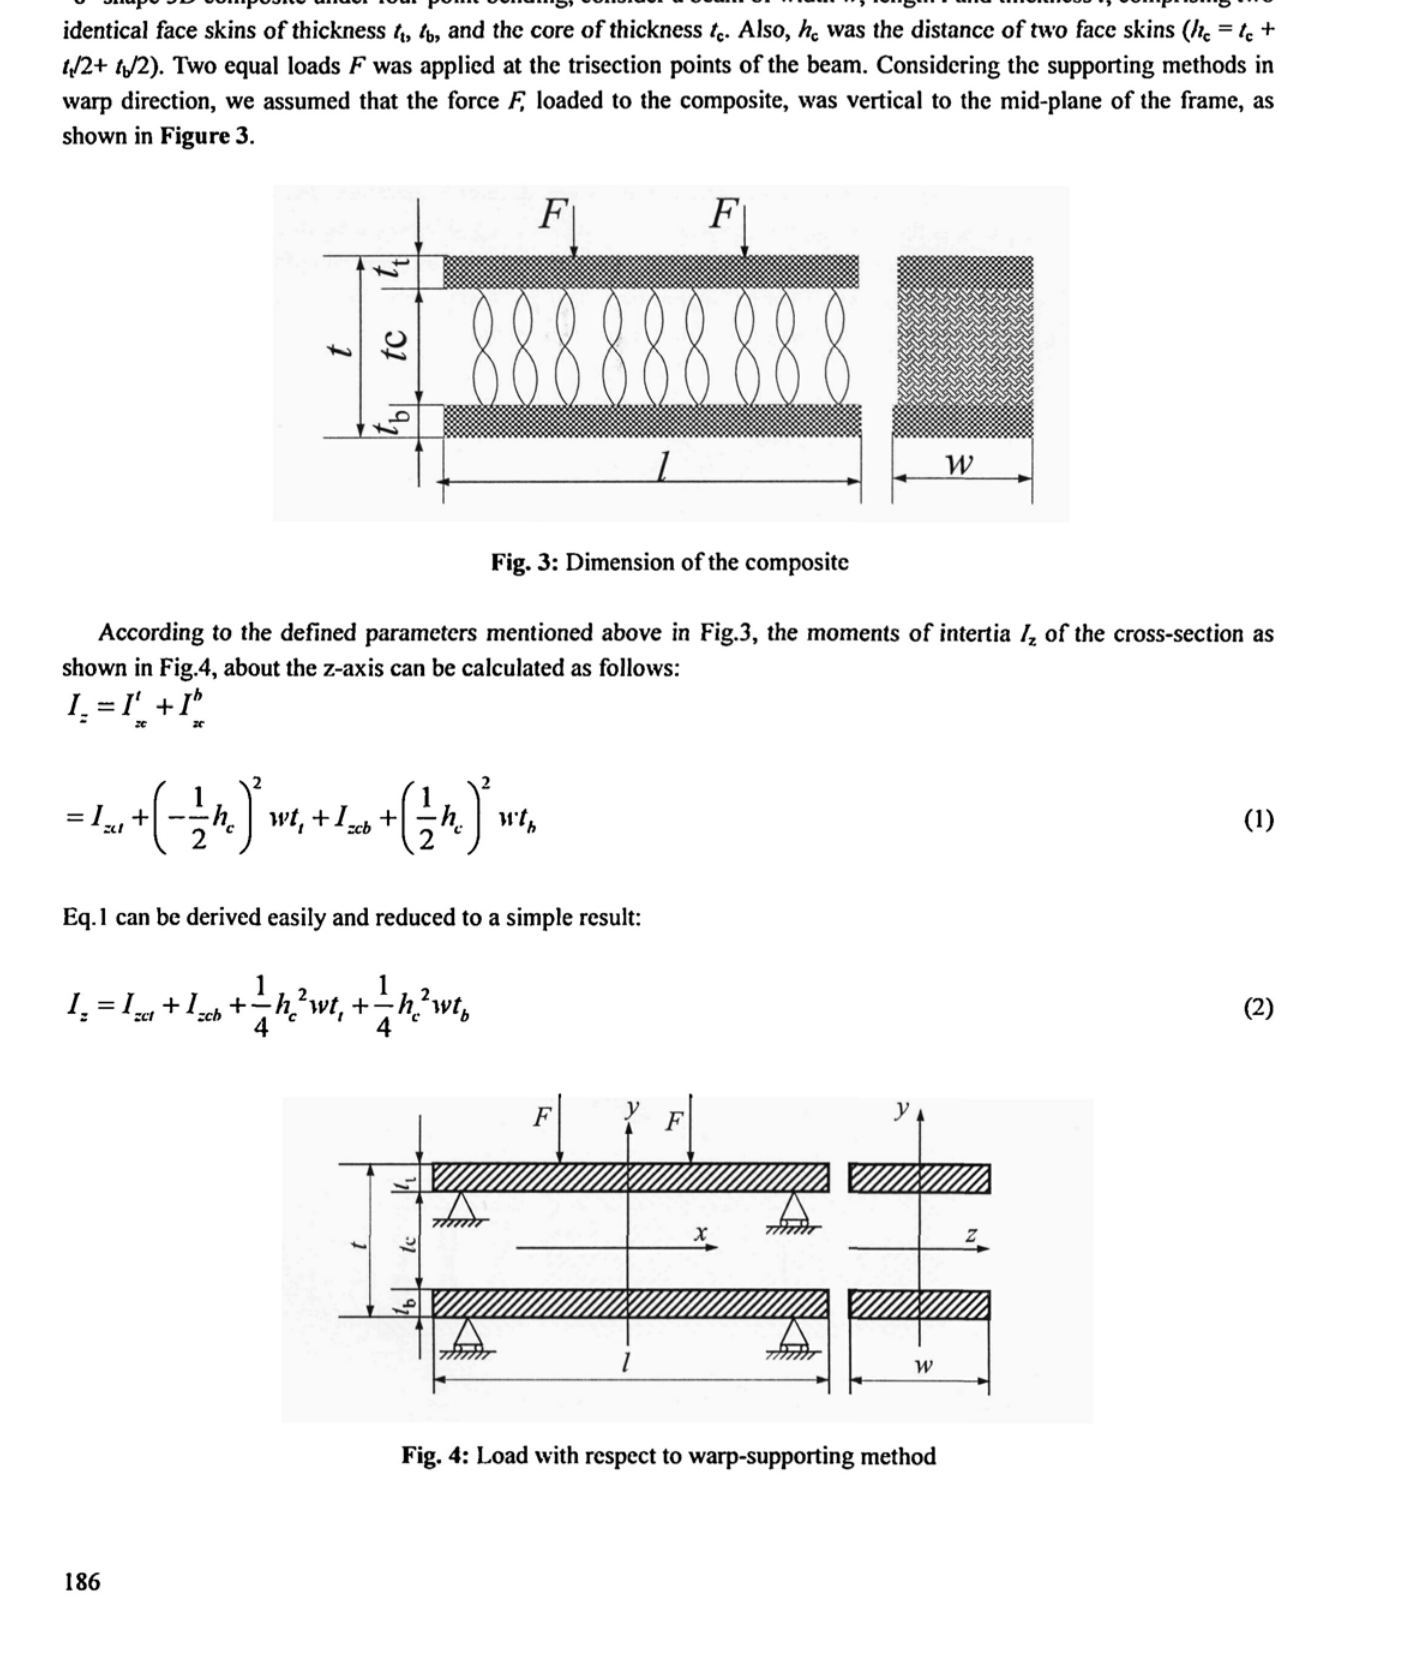
Fig. 3: Dimension of the composite